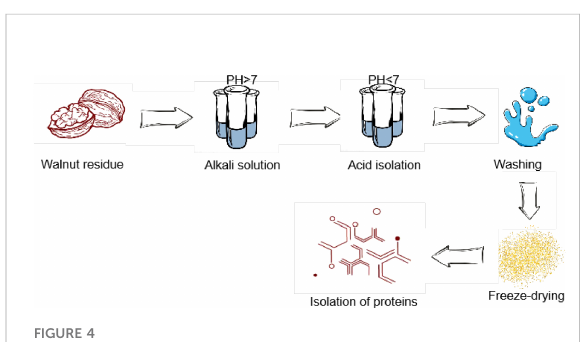
FIGURE 4 Process fl ow diagram for the preparation of Walnut vegetable protein.